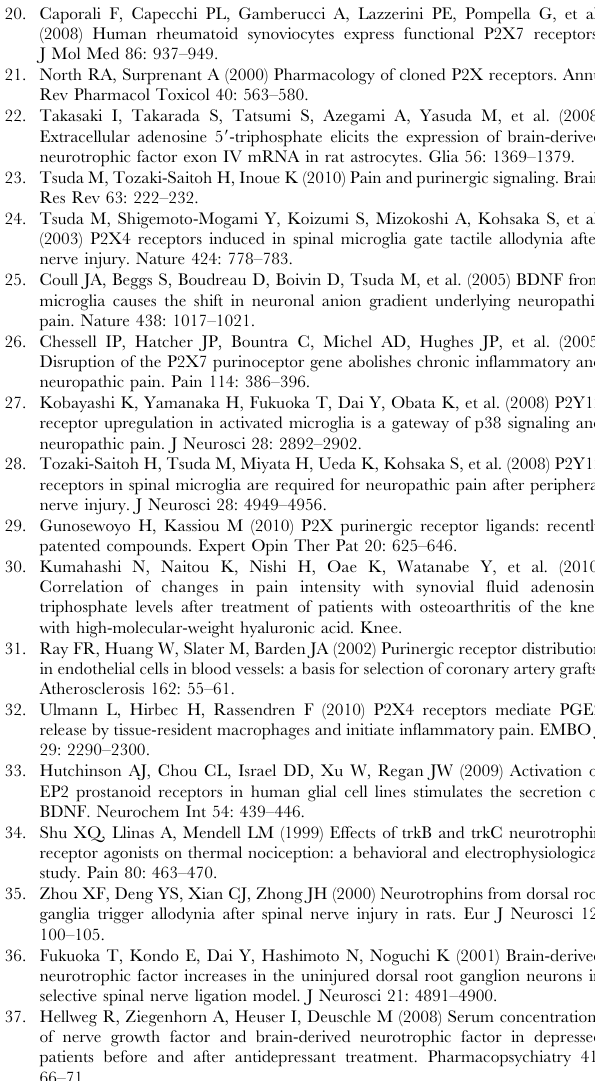
Figure S1 cAMP-responsive element-binding protein (CREB) is not involved in the ATP-induced regulation of BDNF expression. A . OASF were stimulated with ATP (100 m M) for 10 minutes, 2 h, 5 h and 24 h. Western blot analysis of p38 and p44/42 MAPK, phosphorylated p-p38 and p-p44/42 MAPK, as well as phosphorylated p-CREB showed kinase and CREB activation after 10 minutes ATP stimulation. B . The reduction of endogenous CREB levels by siRNA transfection in OASF (n= 3) did not affect the C . ATP-mediated increase in BDNF mRNA expression. Data are shown as means 6 standard deviations. N.s., not significant; **, p , 0.01.